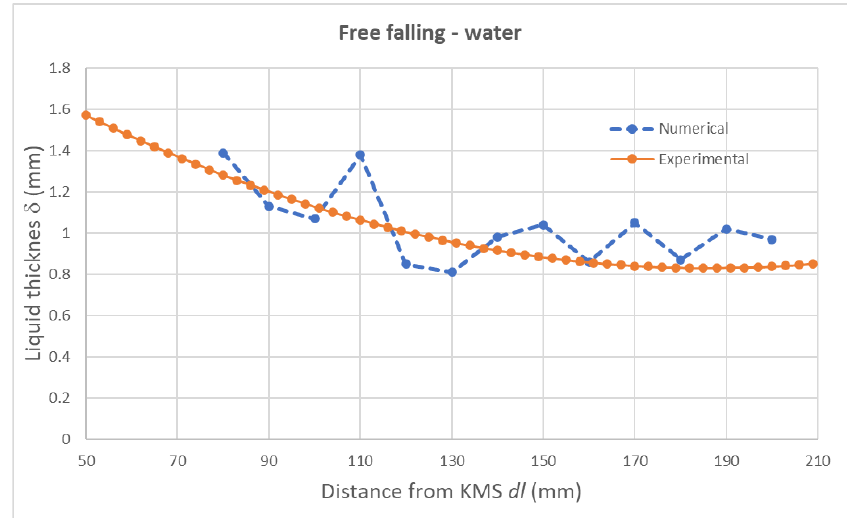
Figure 5. Numerical performance of liquid thickness δ , compared with the experimental fitting